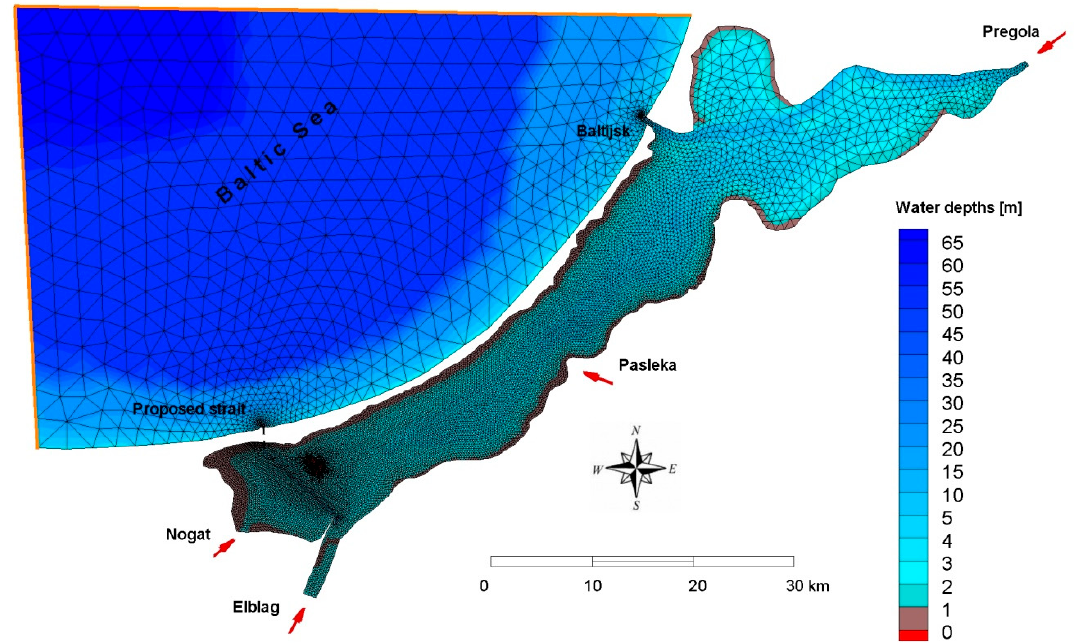
Figure 3. Bathymetry of the Vistula Lagoon and the southern Baltic Sea with the finite element mesh used in the model; the red oval indicates the artificial island; the thick blue line represents WSE boundary conditions; red arrows represent water discharge boundary conditions.